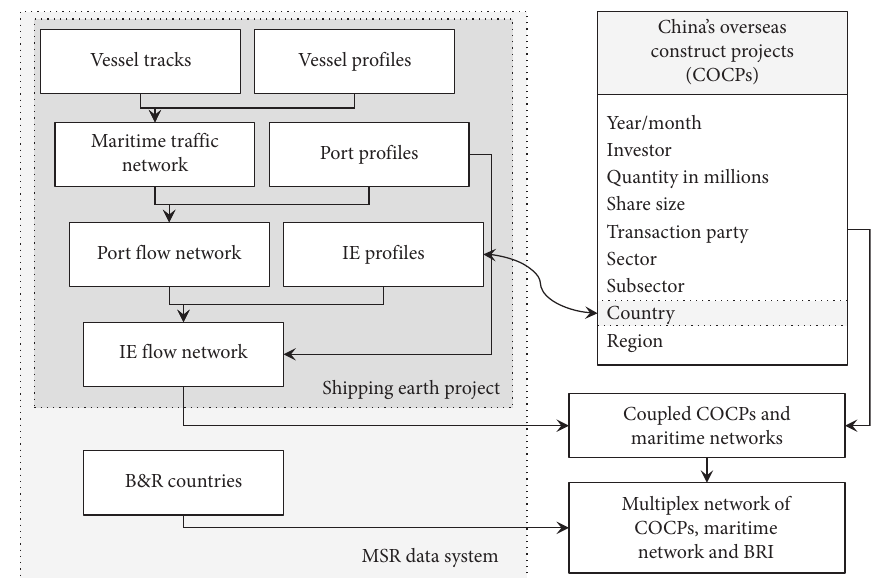
Figure 4: A maritime network based on port network and vessel